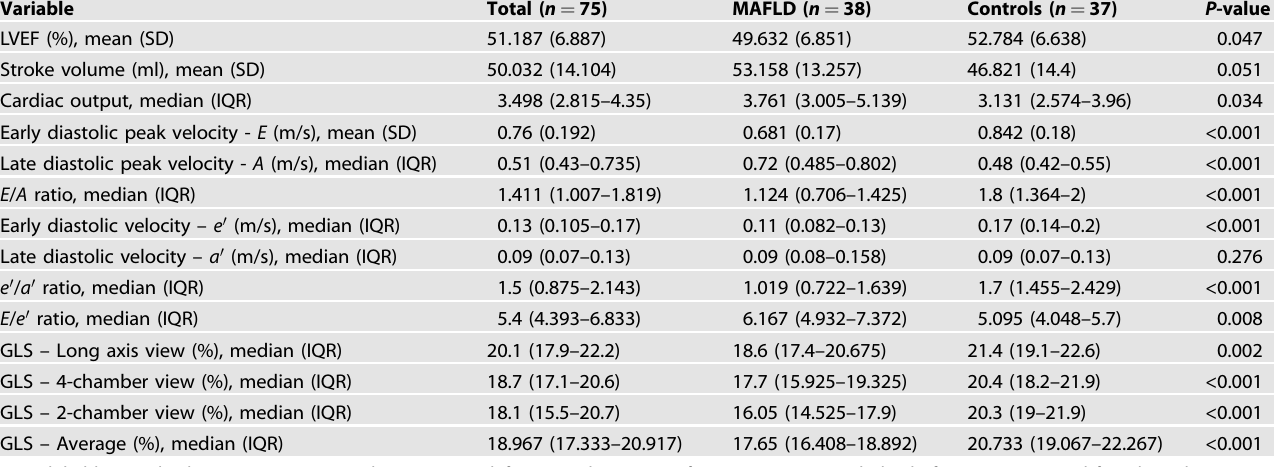
Table 3. Echocardiographic parameters in MAFLD patients vs. controls.